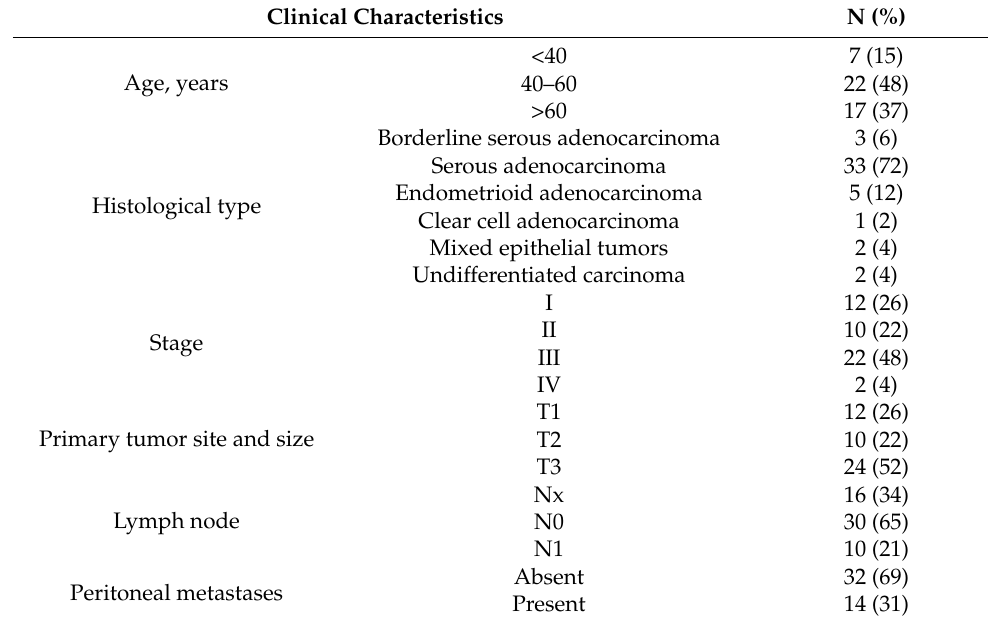
Table 4. Clinical and histological characteristics of OC patients and tissue